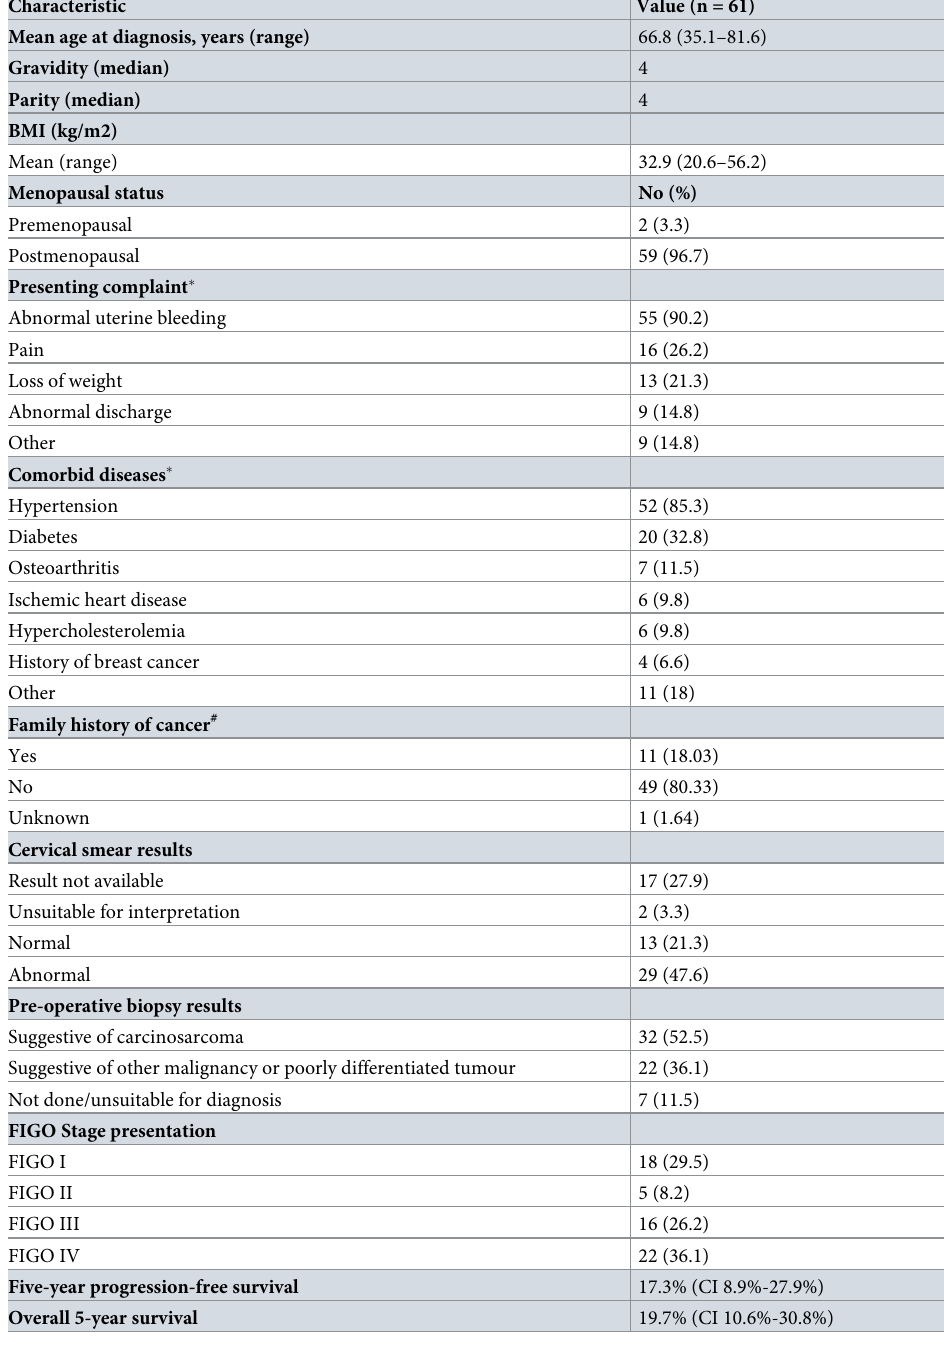
Table 1. Clinical characteristics of the study